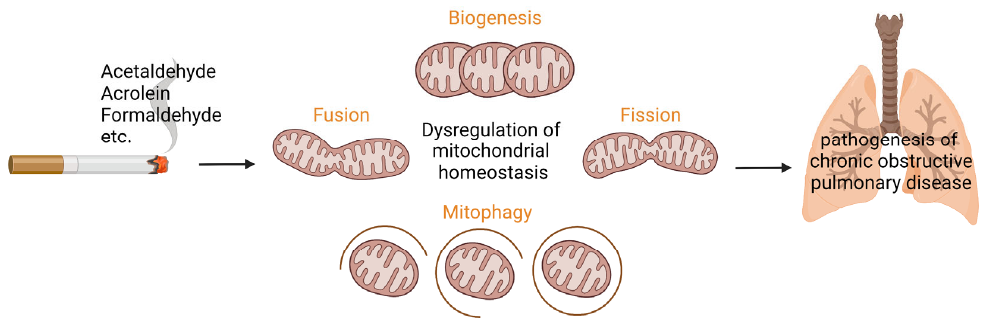
Figure 1. Aldehydes present in cigarette smoke are suggested to induce dysregulation of processes controlling mitochondrial homeostasis in cells of the airways and lungs, respectively the synthesis of new mitochondria (mitochondrial biogenesis) and mitochondrial dynamics including mitochon- drial fusion/fission as well as targeted degradation of damaged or dysfunctional mitochondria (mitophagy). Based on previous (limited) in vitro and in vivo studies, aldehydes-induced mito- chondrial dysfunction has been suggested to be involved in the pathogenesis of chronic obstructive pulmonary disease. Designed with Biorender.com.